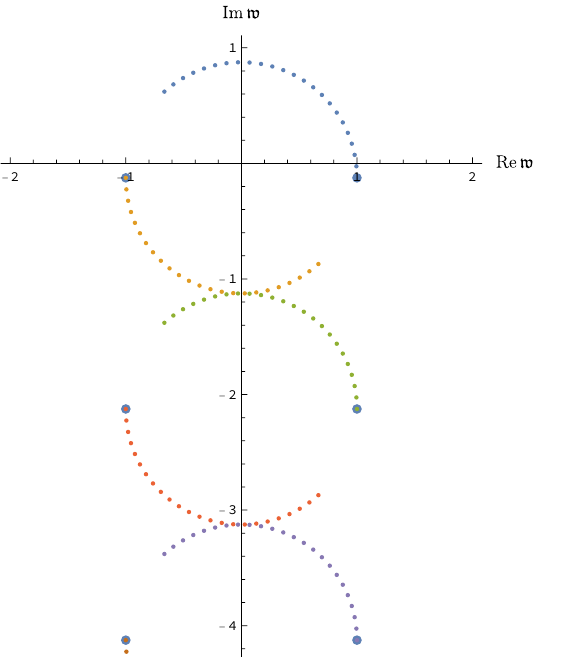
Figure 16 . BTZ quasinormal spectrum for (cid:1) = 1 = 8 in the complex w -plane at complex momentum q = j q j e i(cid:18) , with j q j = 1 and (cid:18) changing from 0 to 3 (cid:25)= 4. The spectrum at (cid:18) = 0 is shown by large dots. critical points correspond to w (cid:0) = w + (i.e. q = in and w = (cid:0) i ( n + (cid:1))) or w (cid:0) c c n 0 q = (cid:0) in and w = (cid:0) i ( n + (cid:1)), n = 1 ; 2 ; : : : ). Thus, the zero mode critical points c c